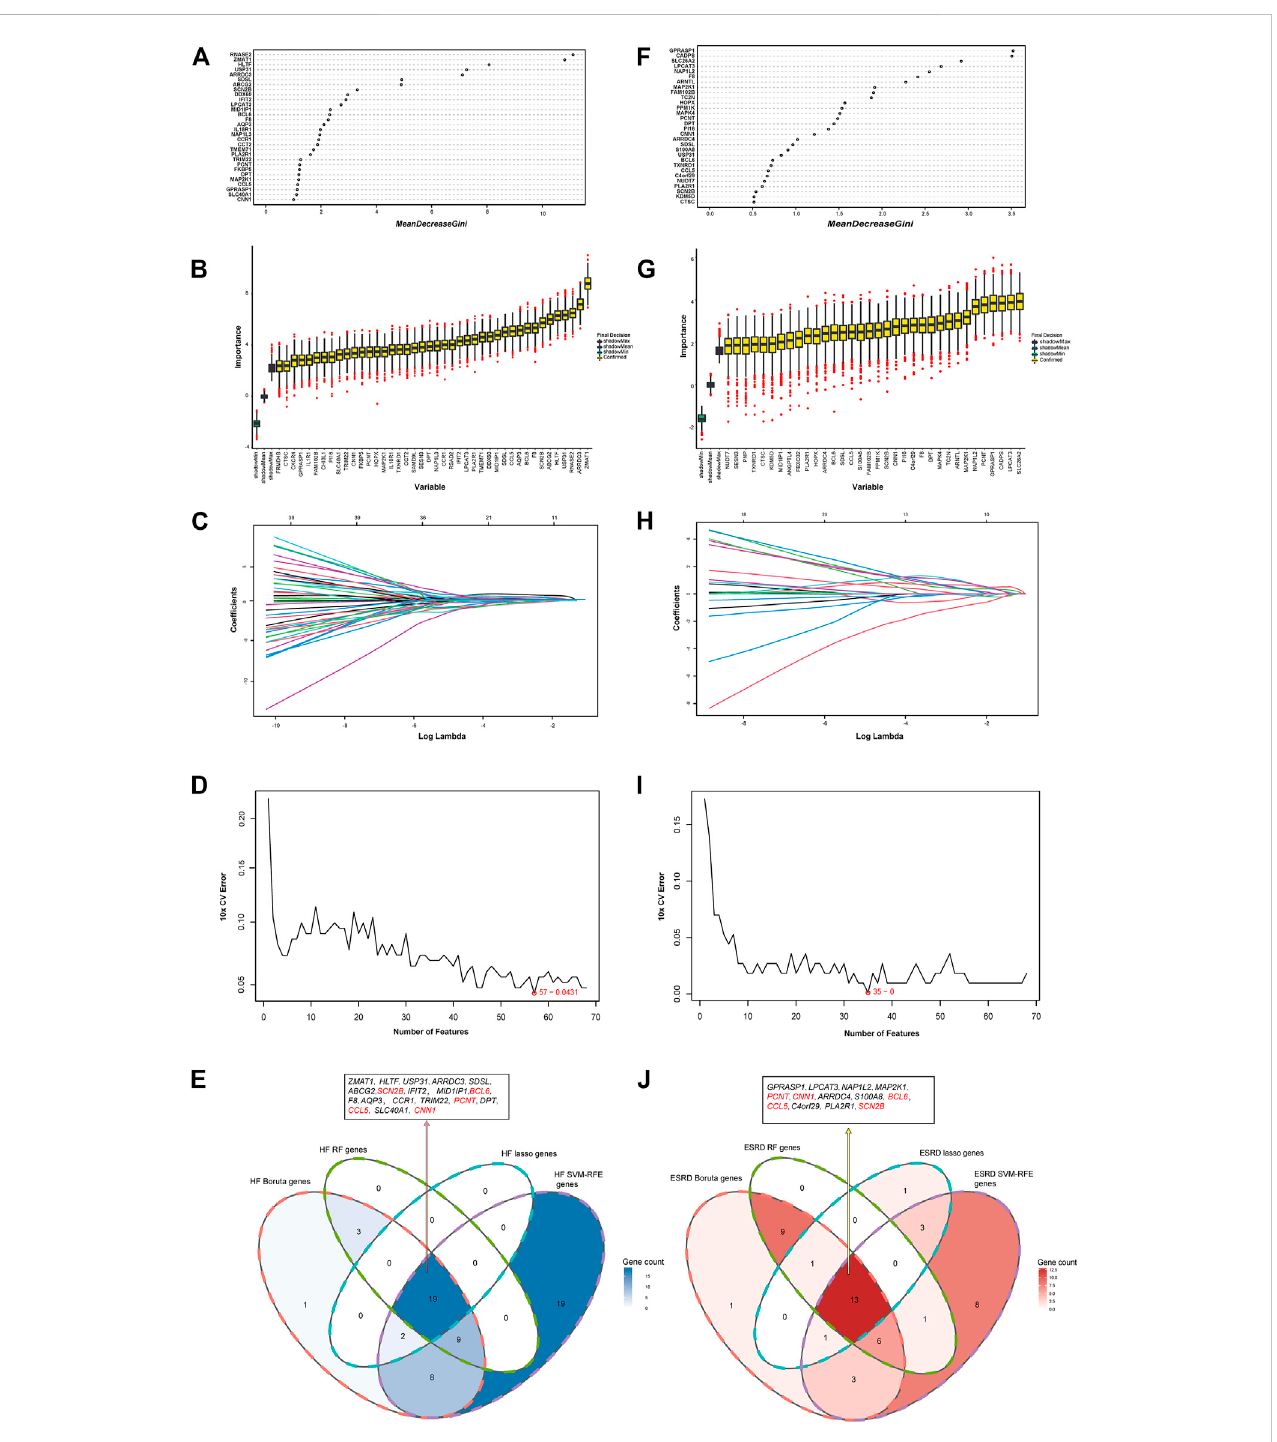
FIGURE 5 Identi fi cationofthehubgeneinHFandESRDdatasets. (A) RFmethodidenti fi edoverlappingDEGsinHFdatasets. (B) Boruta methodidenti fi edcommon DEGs in HF datasets. (C) LASSO method identi fi ed common DEGs in HF datasets. (D) SVM-RFE method identi fi ed 68 common DEGs in HF datasets. (E) Intersection of common DEGs in HF by the four analyses. (F) RF method identi fi ed common DEGs in ESRD datasets. (G) Boruta method identi fi ed common DEGs in ESRD datasets. (H) LASSO method identi fi ed common DEGs in ESRD datasets. (I) SVM-RFE method identi fi ed common DEGs in ESRD datasets. (J) Intersection of common DEGs in ESRD by the four